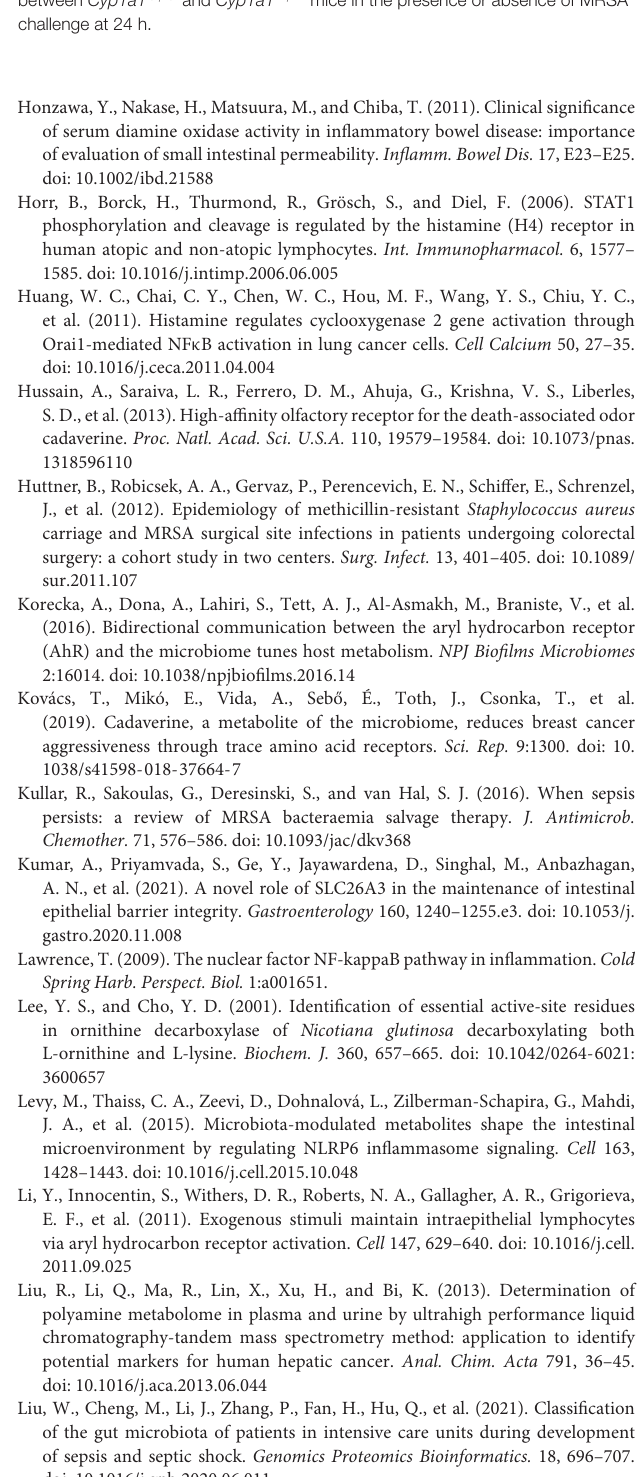
Supplementary Figure 2 | Spearman’s correlation analysis. Correlation analysis between the CAD level and paired E. faecalis abundance in the caecal contents from Cyp1a1 + / + mice (A) and Cyp1a1 − / − mice (B) with MRSA infection. Supplementary Table 1 | Alpha diversity between Cyp1a1 + / + and Cyp1a1 − / − mice in the presence or absence of MRSA challenge at 24 h.